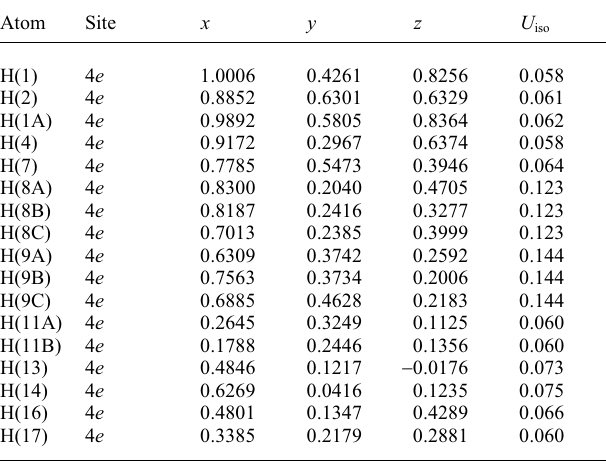
Table 2. Atomic coordinates and displacement parameters (in Å 2 )